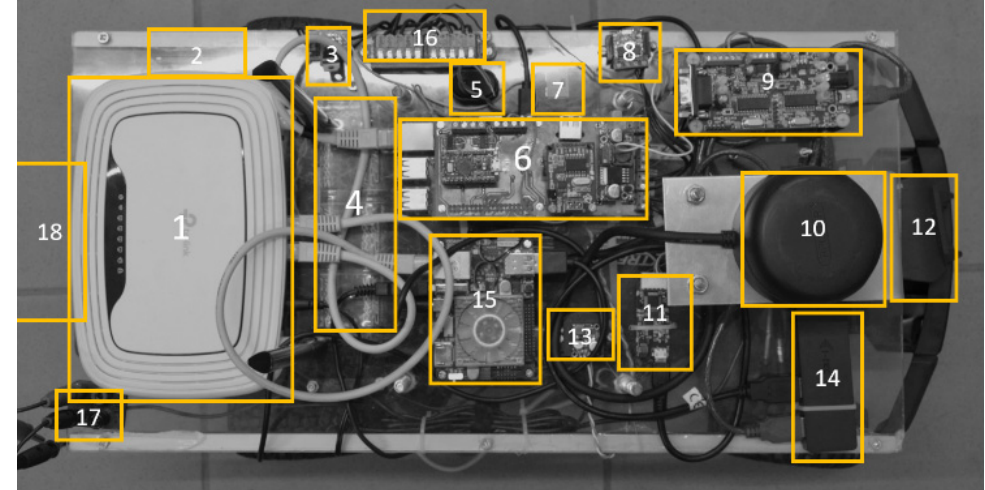
Figure 3. The arrangement of individual modules on the surface of the mobile platform.